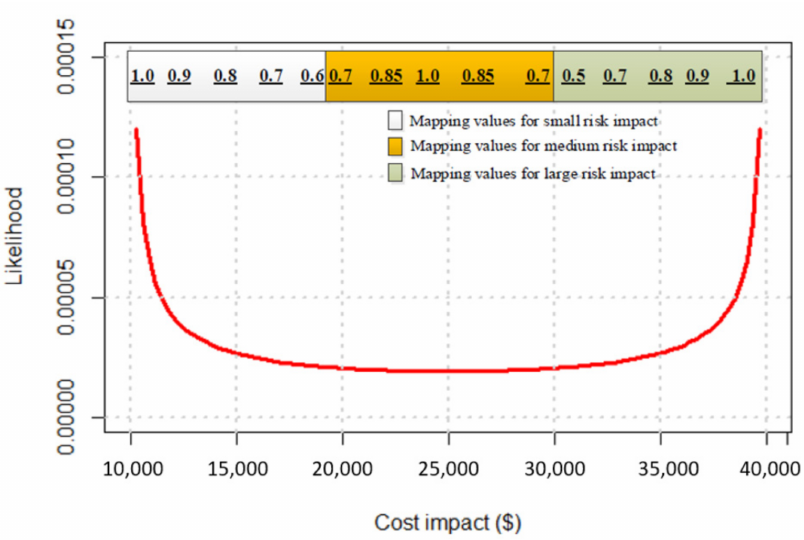
Figure 7. Marginal Beta distribution of cost-risk impact.